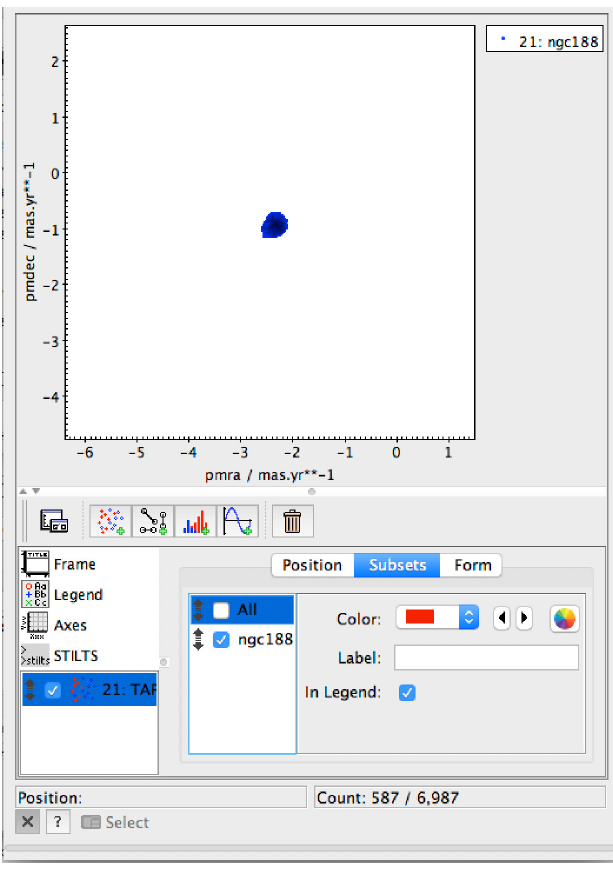
Fig. 68.— Plane Plot with marked